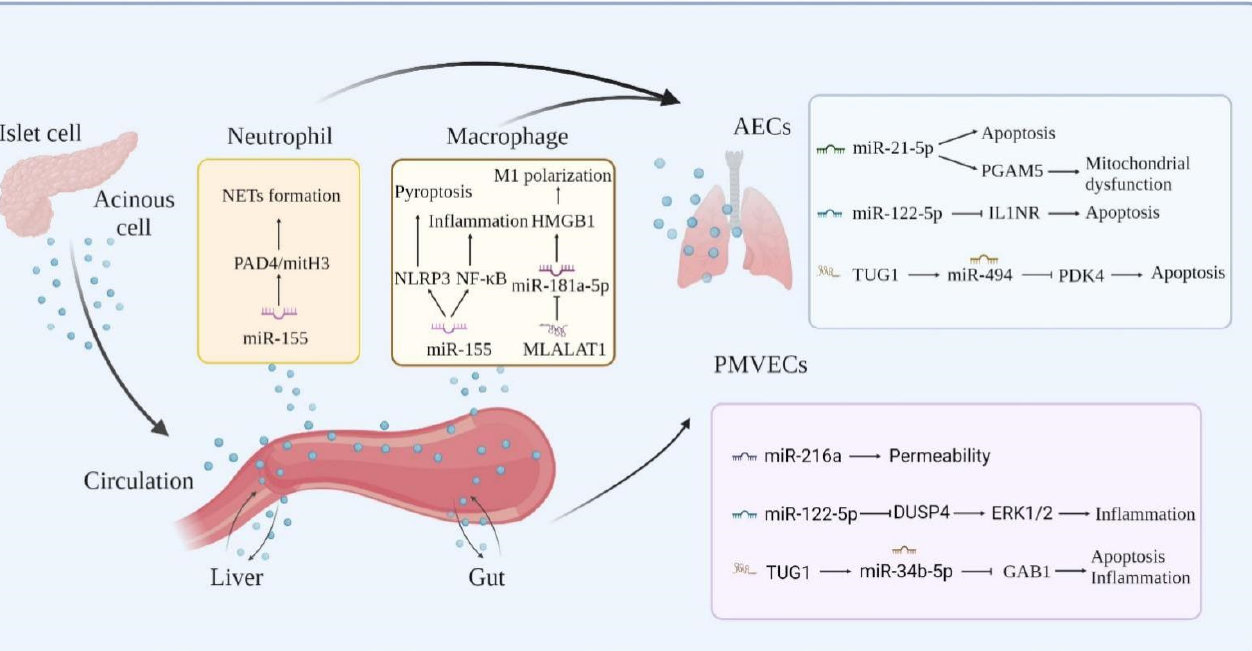
Figure 2. Molecular mechanisms of exosome-ncRNAs in AP-associated ALI.